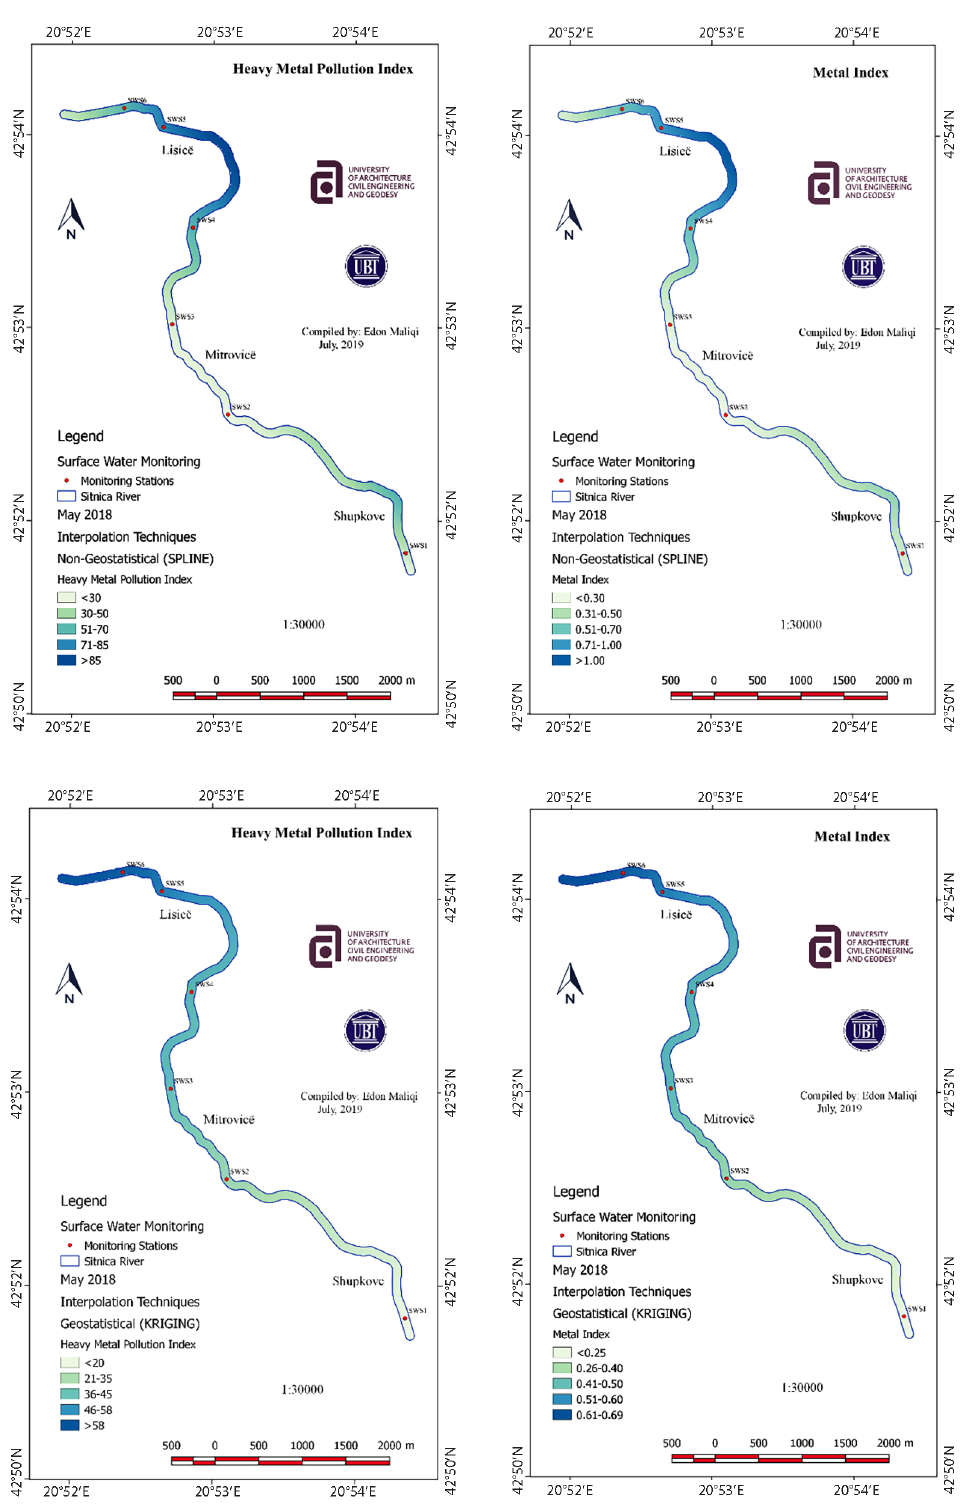
Figure 4. Thematic maps of May (2018) by using Spline and Kriging (HPI &